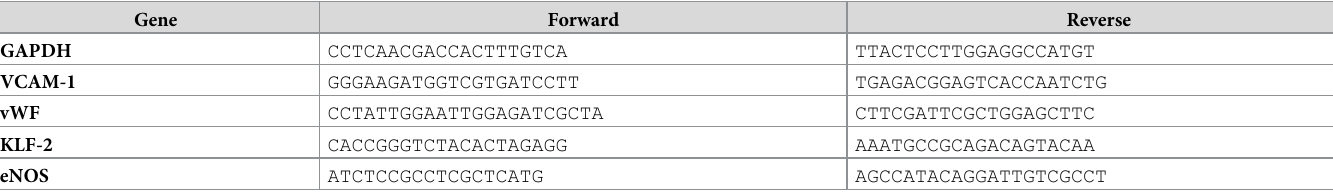
Table 1. Primers used for quantification of EC and ECFC gene expression.